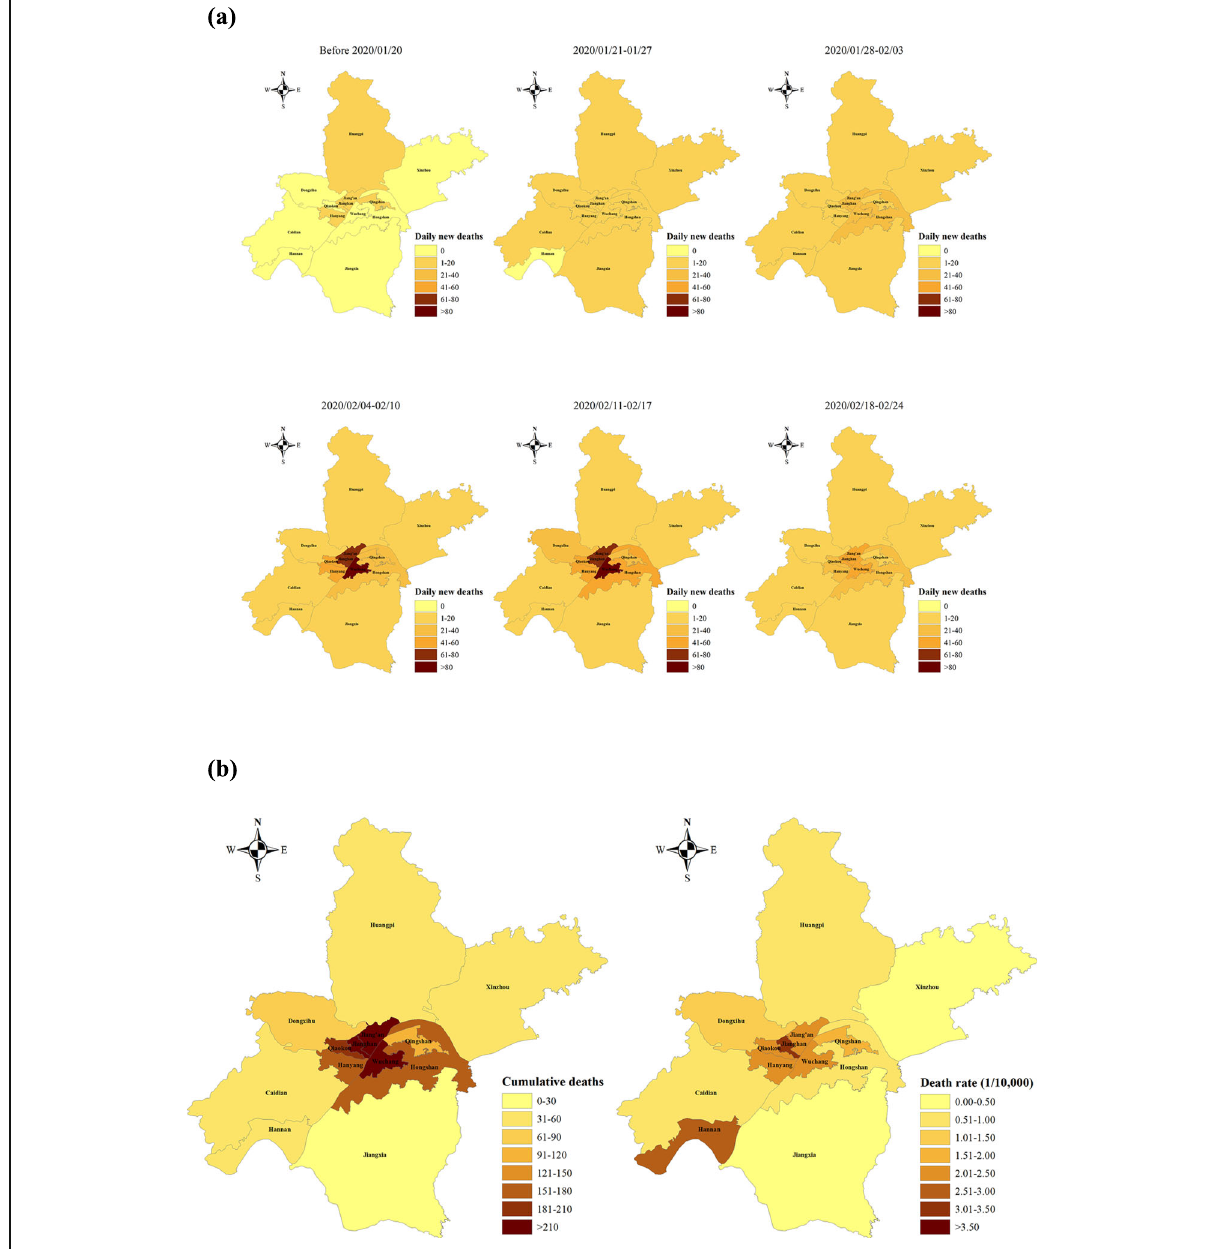
Fig. 4 a The geographic distribution of daily new COVID-19 death in administrative districts of Wuhan (2020/01 / 09 – 2020 / 02/24). b The geographic distribution of cumulative deaths and death rate in